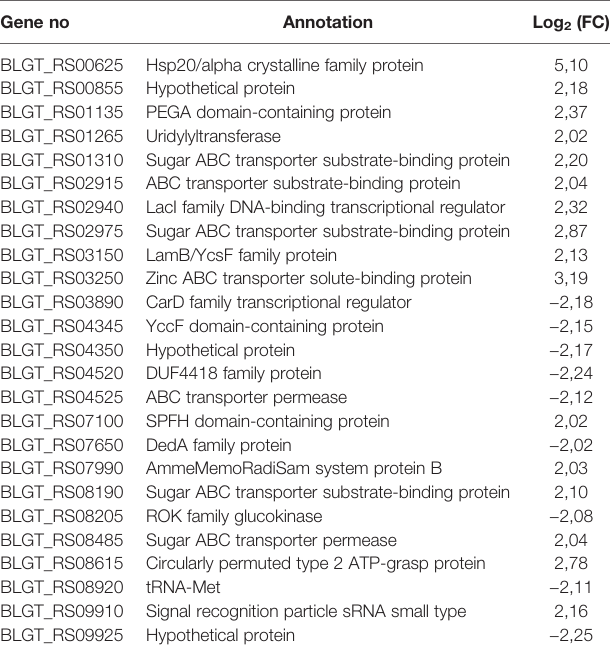
TABLE 1 | Signi fi cantly upregulated and downregulated genes (FC ≥ 2) upon exposure of B. longum subsp. longum GT15 to TNF a compared to controls by